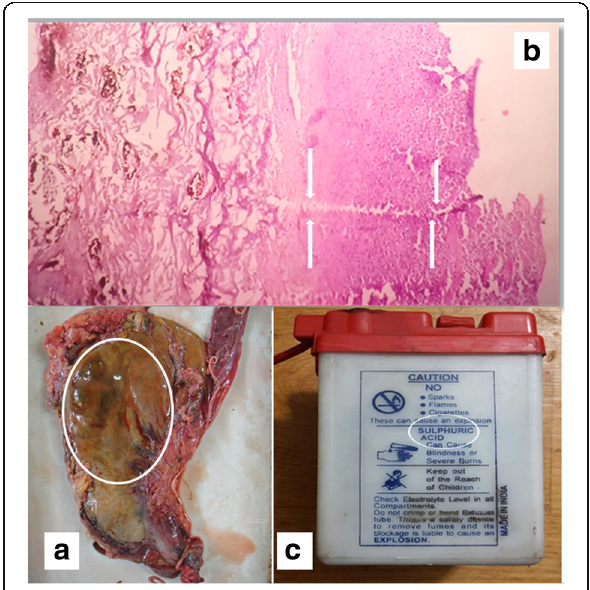
Fig. 3 a Thinning of posterior wall of the stomach. b Histopathology showing transmural necrosis of the stomach wall (H & E staining – 100x). c The battery acid used for the purpose showing sulphuric acid as the